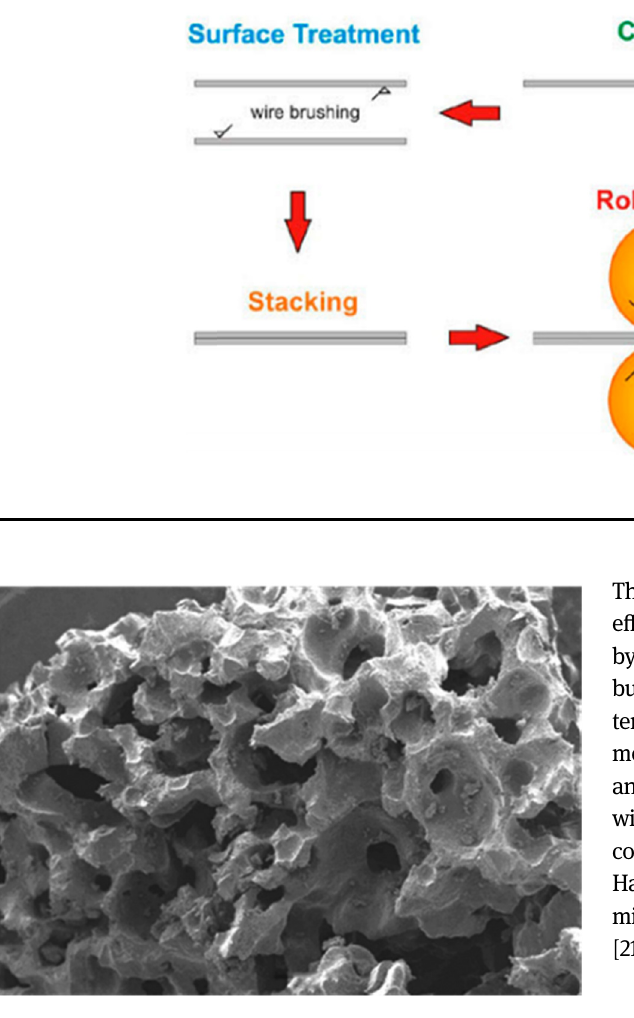
Figure 12: SEM image of polyurethane [ 152 ]